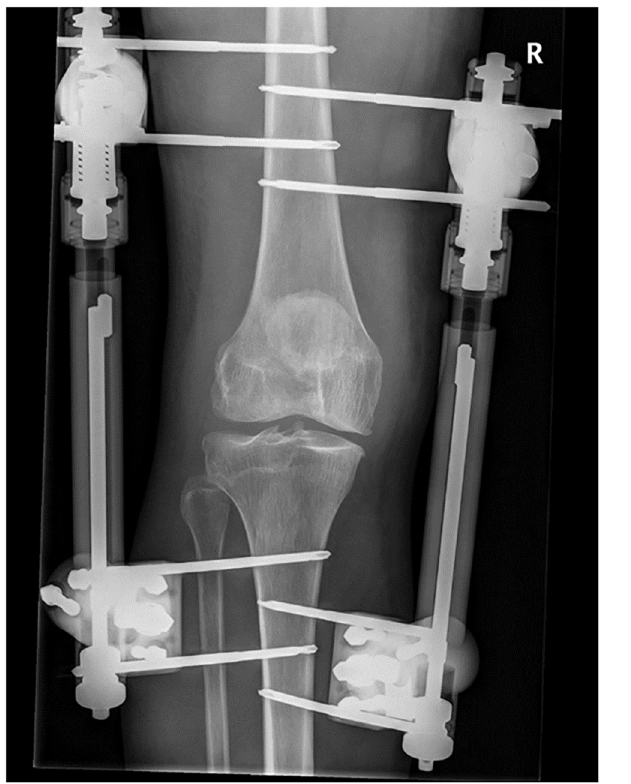
Fig 1. Representative radiograph of the external distraction frame in